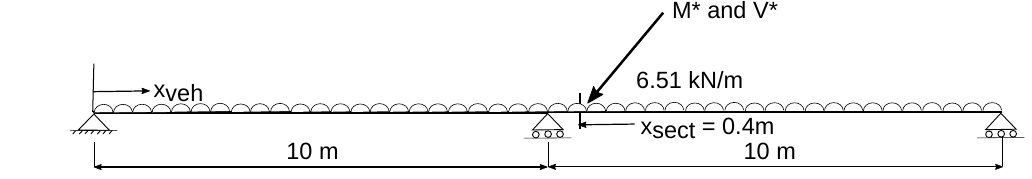
Figure 7. Two-span bridge beam with factored self-weight.